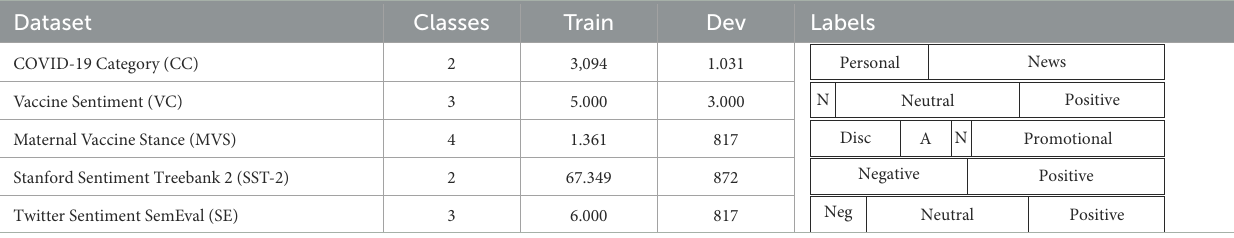
TABLE 1 Overview of the evaluation datasets.